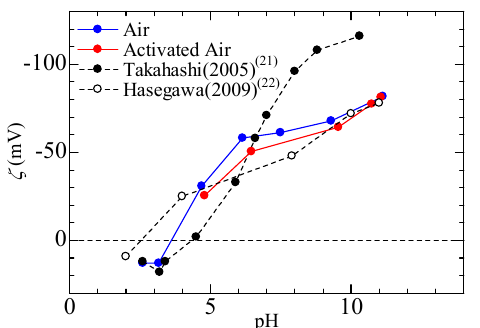
Fig. 3 Relationship between ζ -potential of the microbubble for various solution pH.